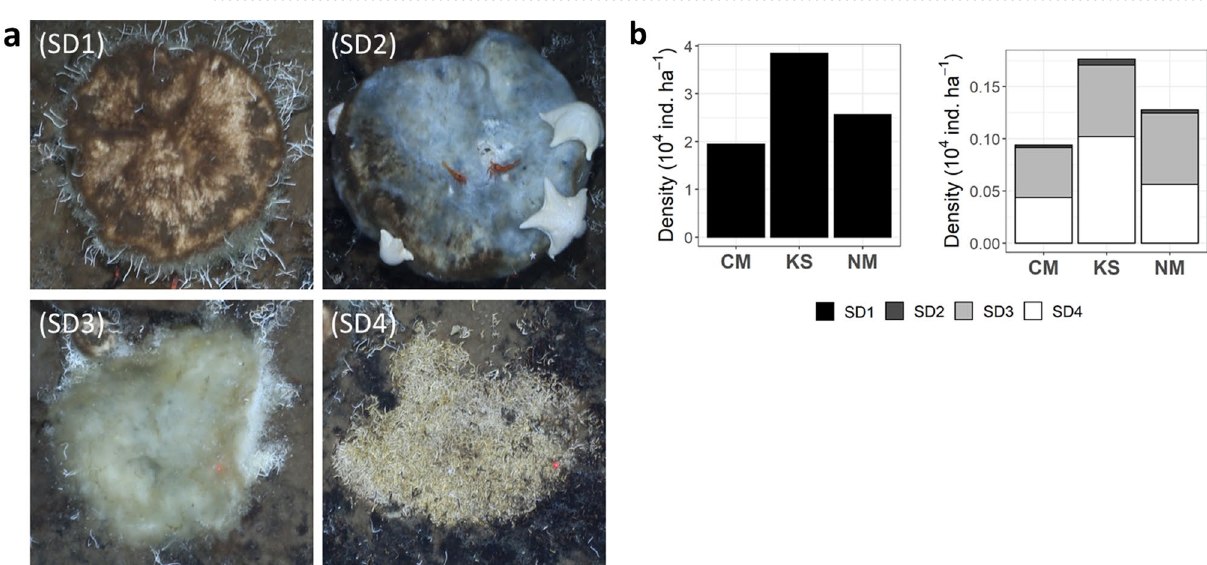
Figure 5. ( a ) Images of different stages of sponge decay observed across the three seamounts. (SD1) Healthy big Tetractinellida gen. indet. sponge, (SD2) Tetractinellida sponge partly covered with a white/blue microbial mat, (SD3) whitish-grey/bright yellow, collapsed sponge, (SD4) polychaetes covering the sponge remains. ( b ) Density of big sponges in different stages of decay/bleaching (in ca. 1000 specimens) across the three Arctic seamounts ( CM Central Mount, KS Karasik Seamount, NM Northern Mount). For plotting purposes, densities of SD1 are shown in the left part of panel ( b ) and densities of SD2–SD4 are presented in the right part of panel ( b